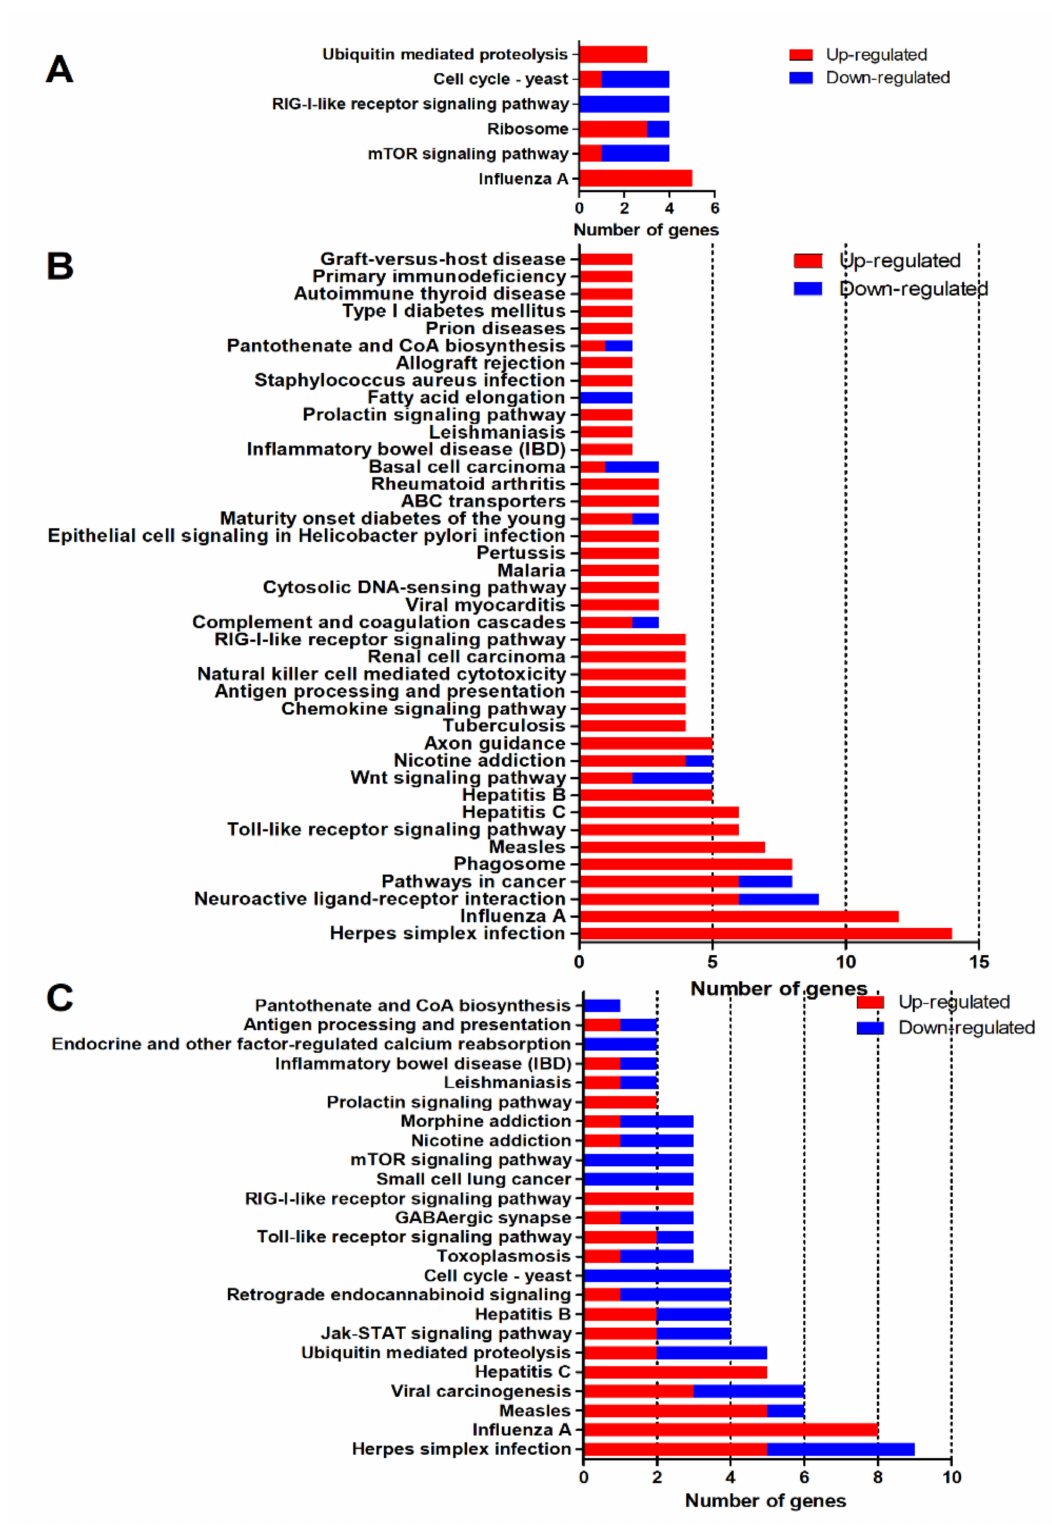
Figure 5. Kyoto Encyclopedia of Genes and Genomes (KEGG) enrichment analysis of DEGs ( p < 0.05). ( A ) Six KEGG terms were significantly enriched at 12 hpi. ( B ) Forty KEGG terms were significantly enriched at 24 hpi. ( C ) Twenty-four KEGG terms were significantly enriched at 48 hpi. The red portion of The bar represents The number of upregulated genes, and The blue portion of The bar represents The number of downregulated